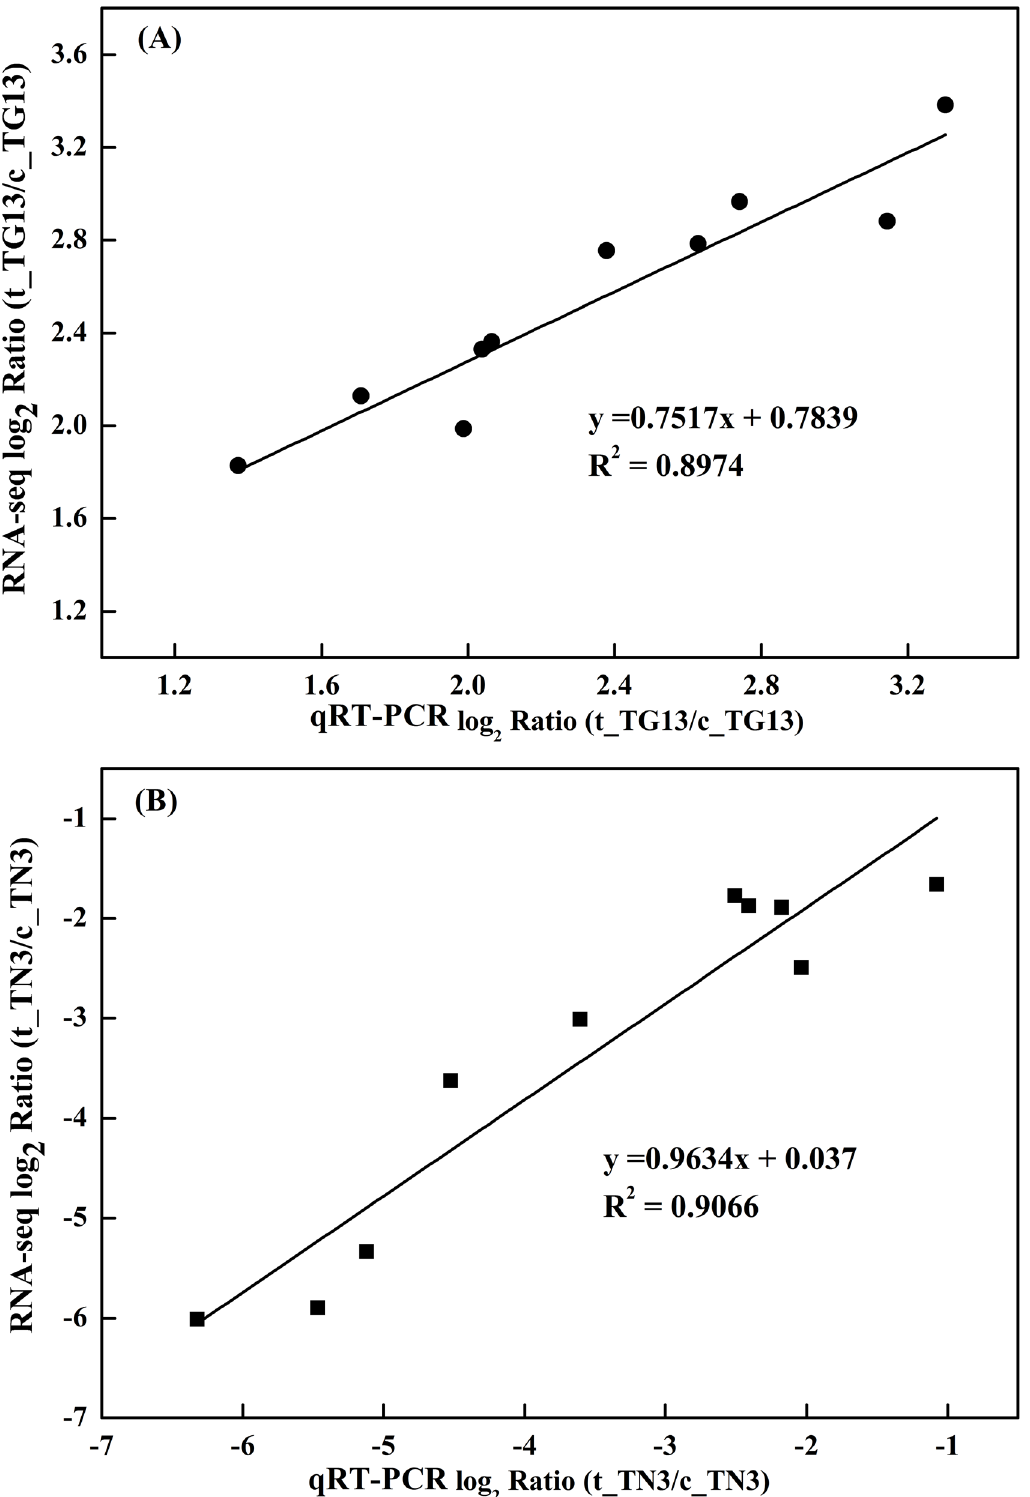
Fig 6. qRT-PCR validation of ten randomly selected differentially expressed genes identified by Illumina high throughput RNA-sequencing. (A): Rhodococcus sp. TG13; (B): Rhodococcus sp. TN3.